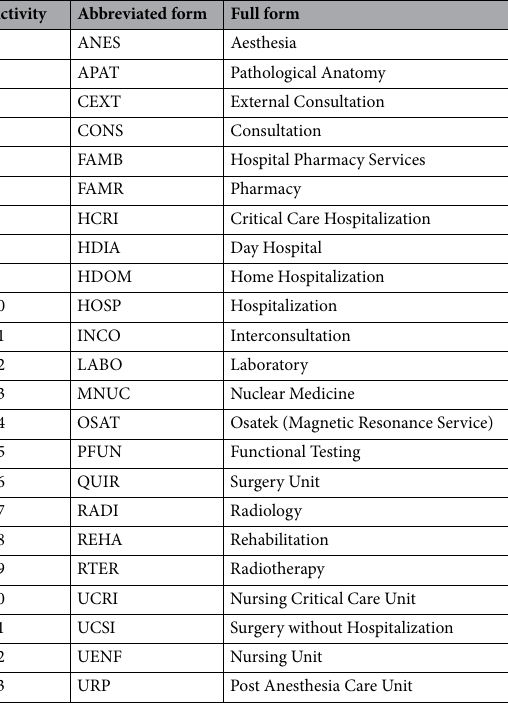
Table 1. Description of the clinical